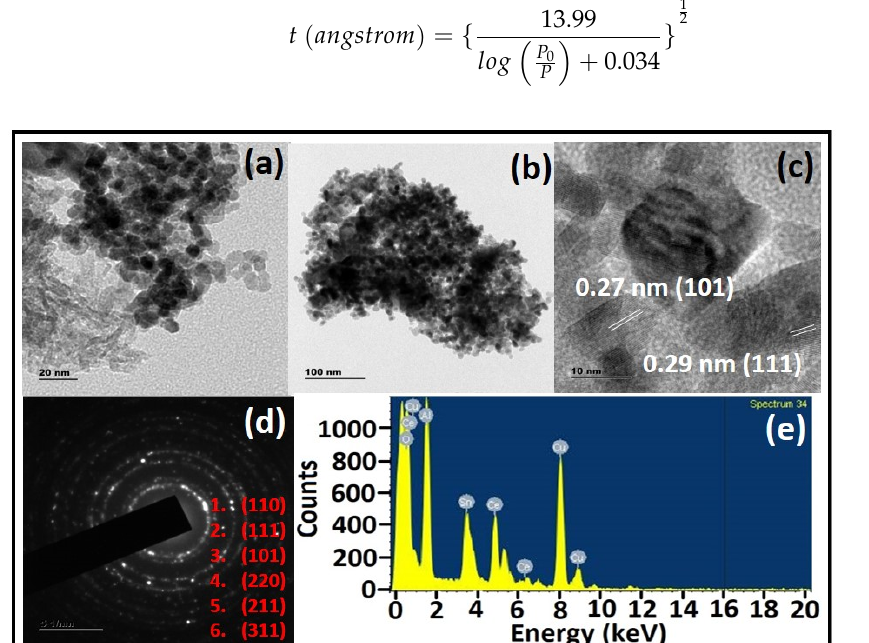
Figure 4. ( a – c ) HRTEM images of CTA-55, ( d ) SAED pattern of CTA-55, and ( e ) EDS spectra of CTA-55.